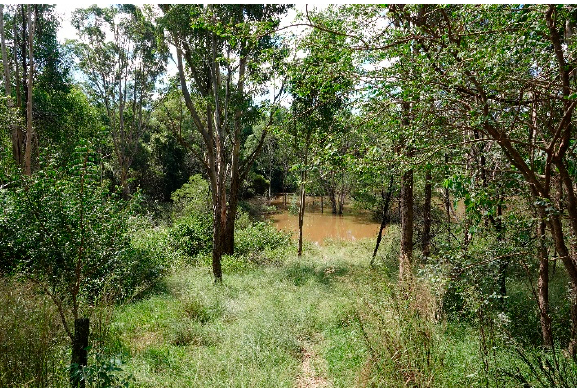
Figure 1. Yellomundee Aboriginal Place, Shaw’s Creek. (With permission - Mark Parry (Photogra-